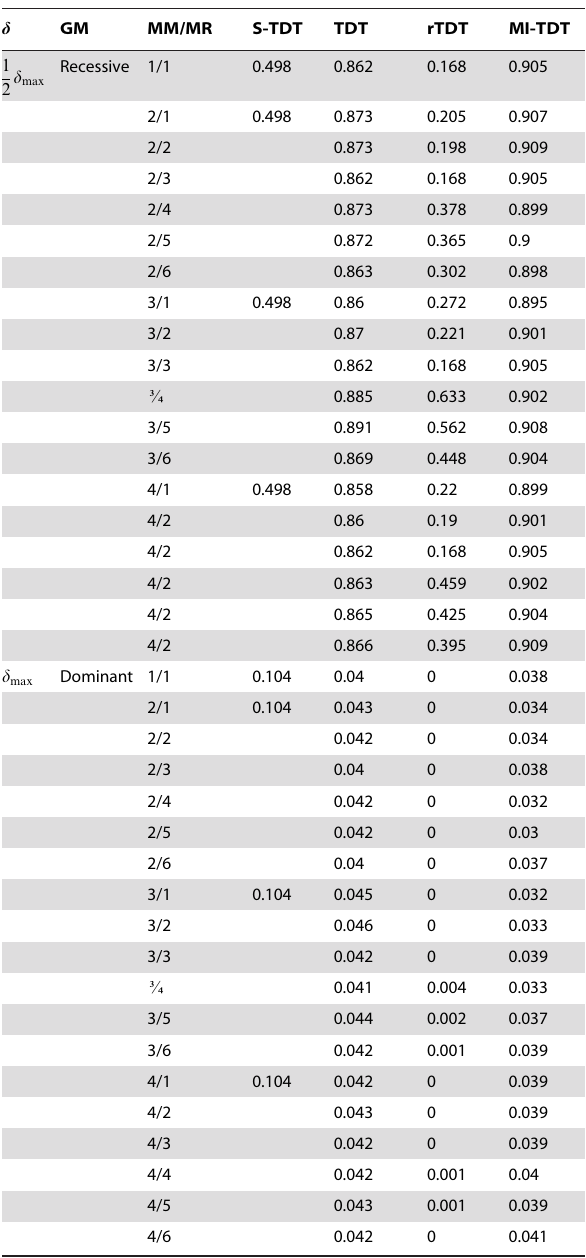
Table 13. Power values at 5% significance level when alternative hypothesis is h ~ 0 .